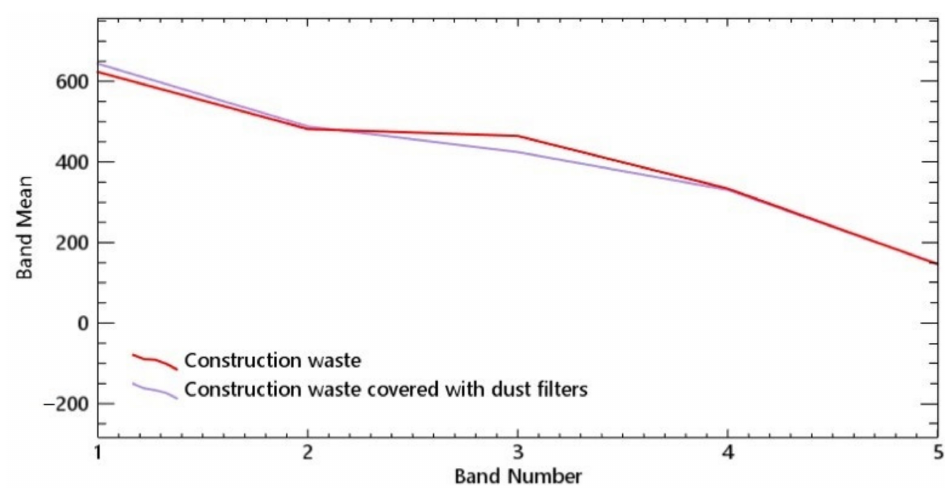
Figure 28. Spectral mean distribution of construction waste covered with dust screen and exposed construction waste.